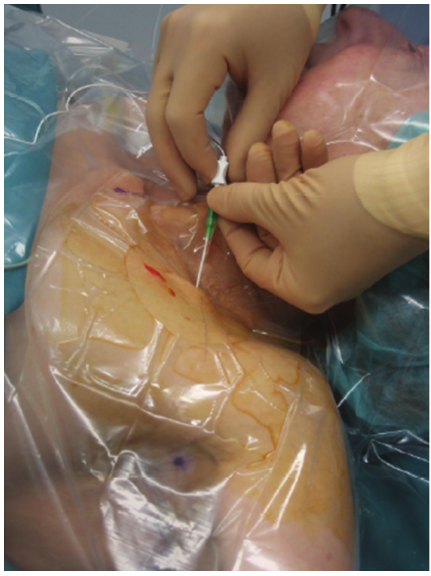
Figure 3: Cannula over the needle